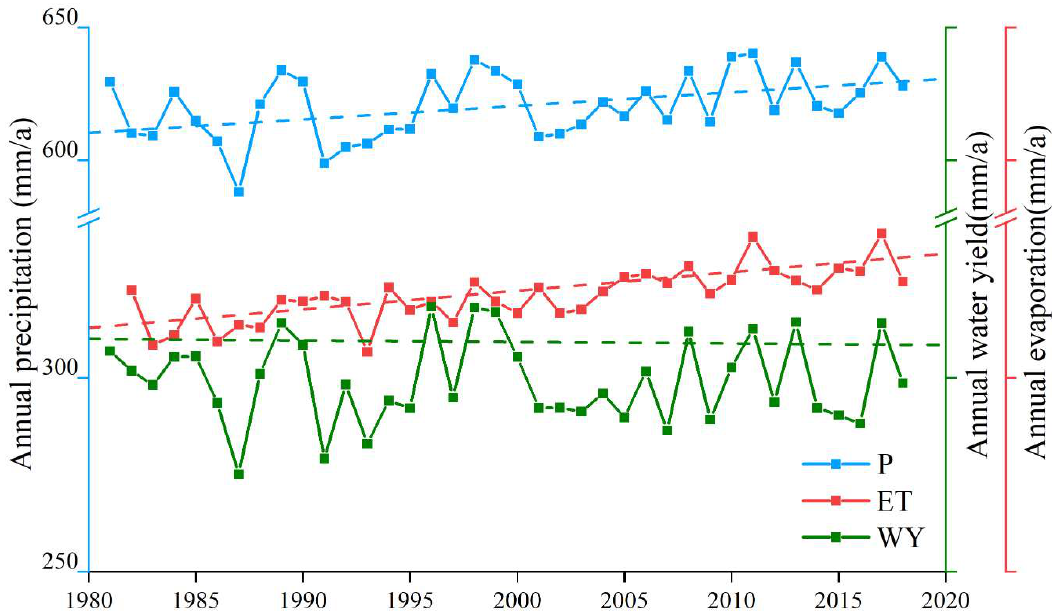
Figure 3. Temporal variabilities of annual terrestrial water yield (WY), precipitation (P), and evap- otranspiration (ET) globally from 1981 to 2018. The colored dots and dash lines denote the yearly average values and the linear trends of the variables, respectively.